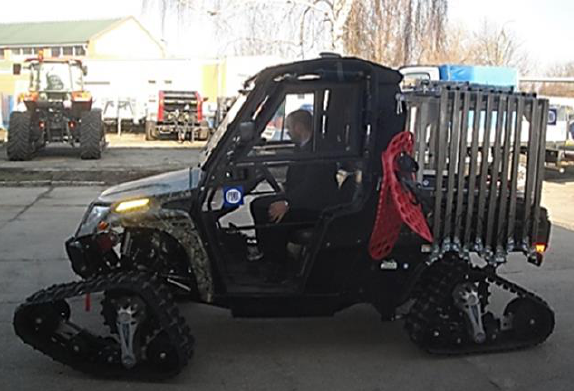
Figure 4. Prowler 700HDX rebuilt into a tracked mini tractor for biomass trains. Note the (red) mud shoes hanging on back of cab. Photo: PIMR archive. The field trials were carried out on a sunny